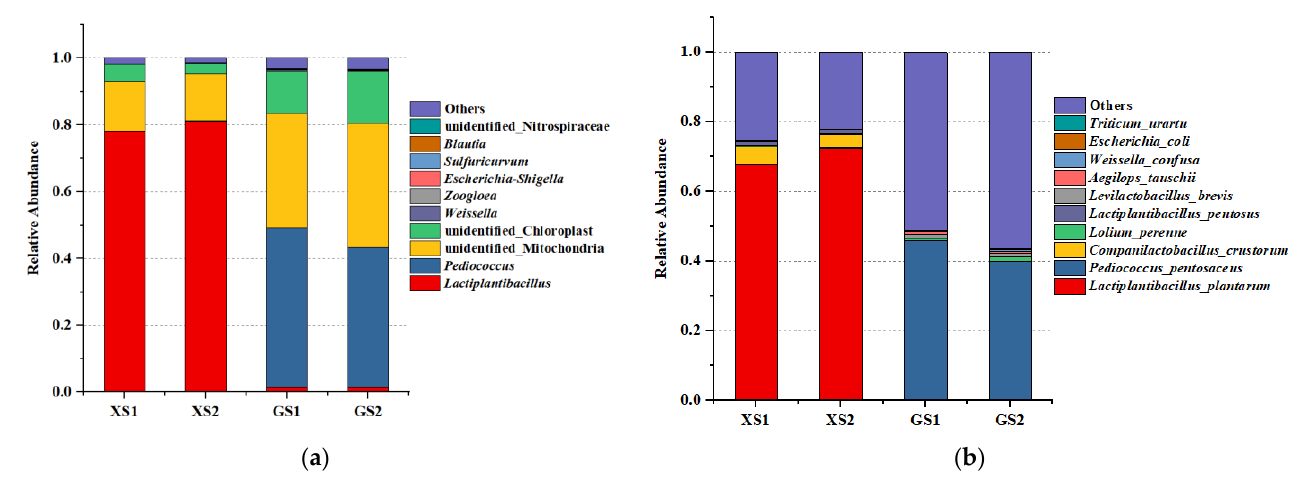
Figure 6. Relative abundance of microbial communities in different sourdoughs (( a ): at the genus level, ( b ): at the species level).